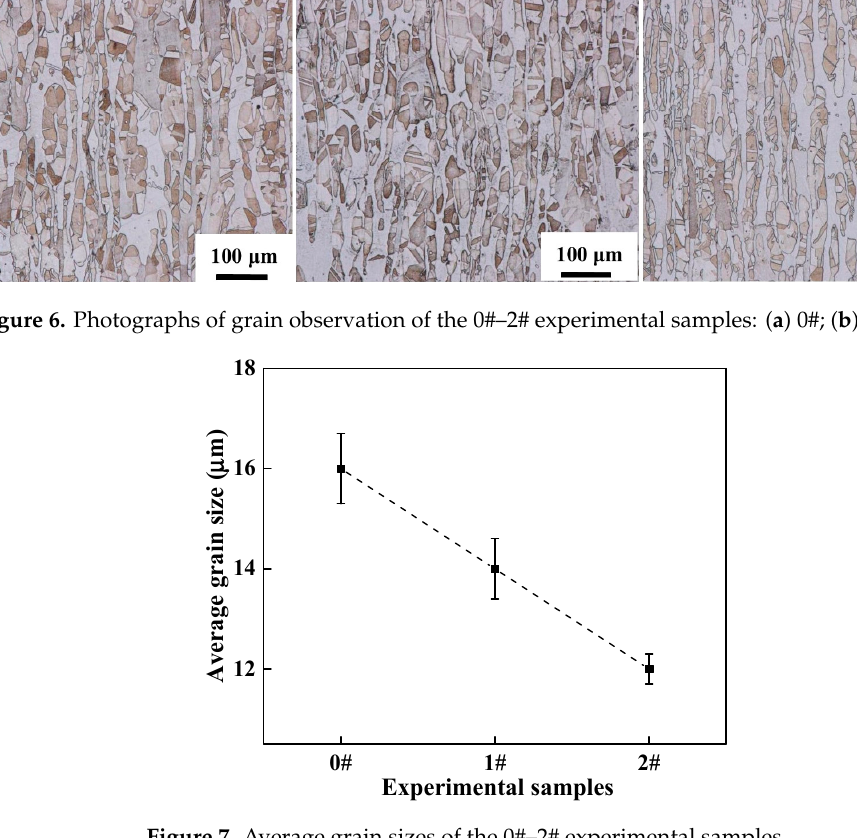
Figure 7. Average grain sizes of the 0#–2# experimental samples.